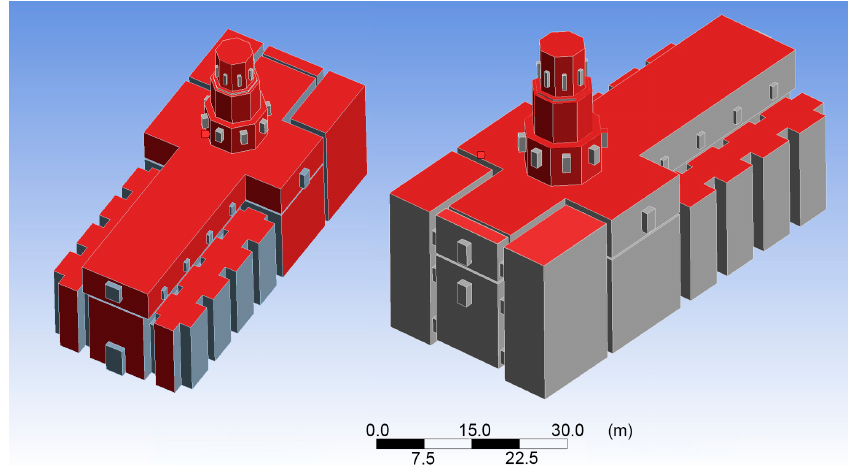
Figure 4. Surfaces with a high degree of exposure to the elements (red colour).